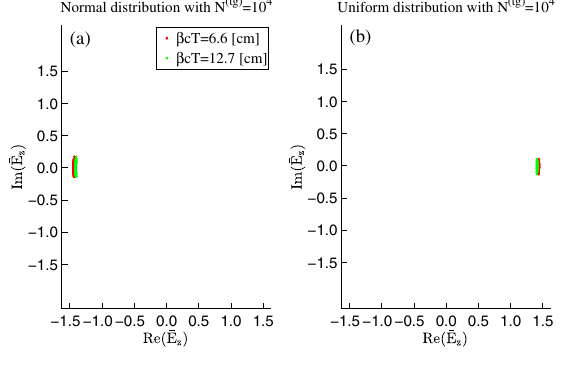
FIG. 5. The same as Fig. 3 but with N ð tg Þ ¼ 10 4 .